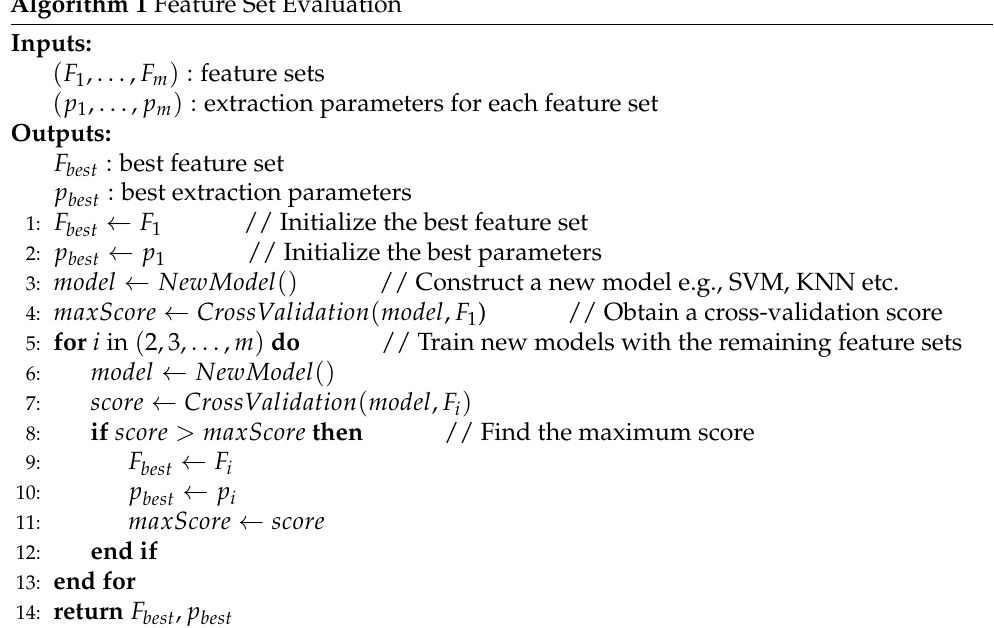
Algorithm 1 Feature Set Evaluation